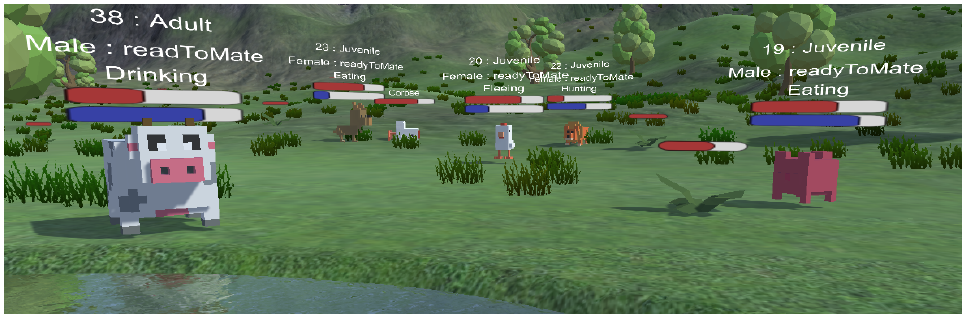
Figure 6. The circle of life in a predator–prey habitat with usual and everyday metabolism process (eating and drinking) alongside with extreme hunting and fleeing